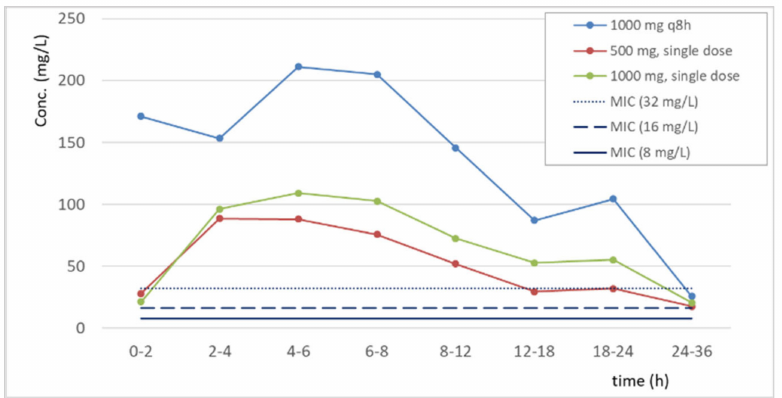
Figure 3. Mean concentrations of fosfomycin in the urine samples in comparison to MIC values of 8, 16, and 32 mg/L. For 1000 mg given every 8 h, sampling starts after the administration of the last